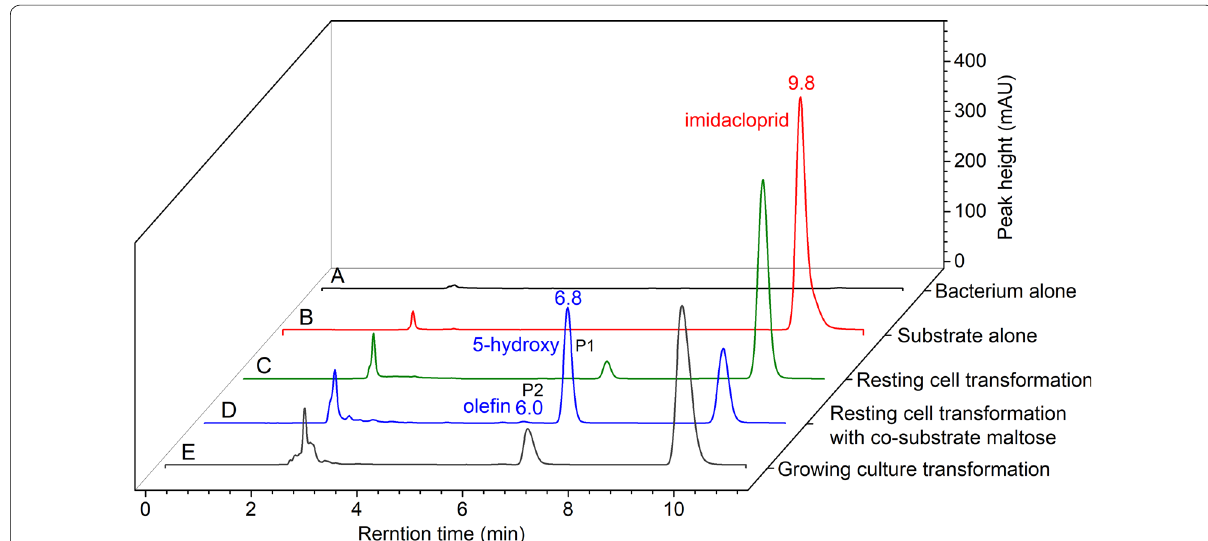
Fig. 3 High-performance liquid chromatograms of imidacloprid degradation by resting cells and growing culture of H. latericoloratus CGMCC 16346. a Bacterial control without imidacloprid in resting cell transformation. b Substrate control without bacterial inoculation. c Resting cell transformation of imidacloprid by H. latericoloratus CGMCC 16346. d Resting cell transformation of imidacloprid by H. latericoloratus CGMCC 16346 in the presence of 2% maltose. e Transformation of imidacloprid by growing